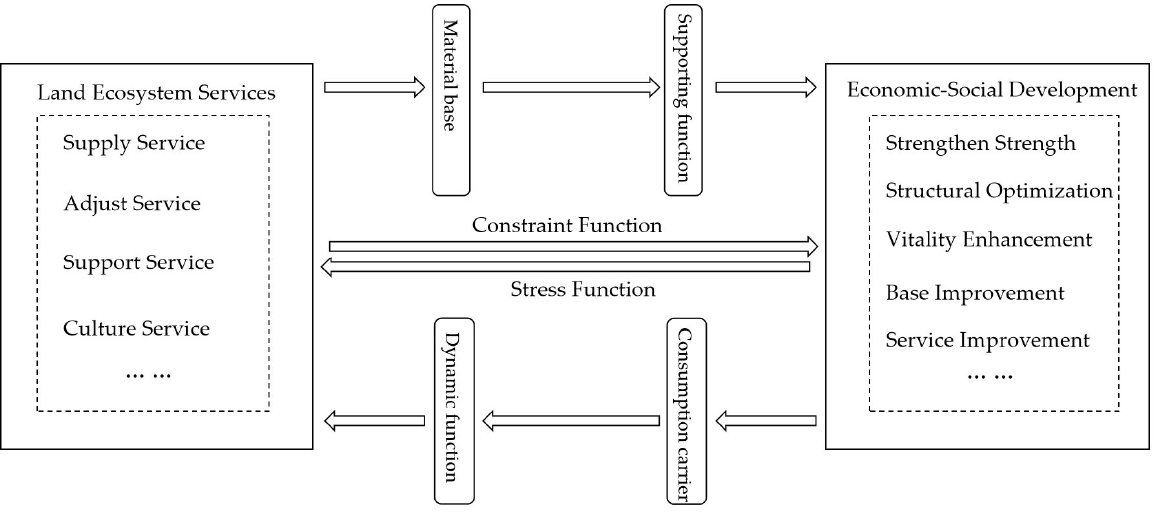
Figure 1. Relationship of the coupling coordination between land ecosystem services and economic– social development.